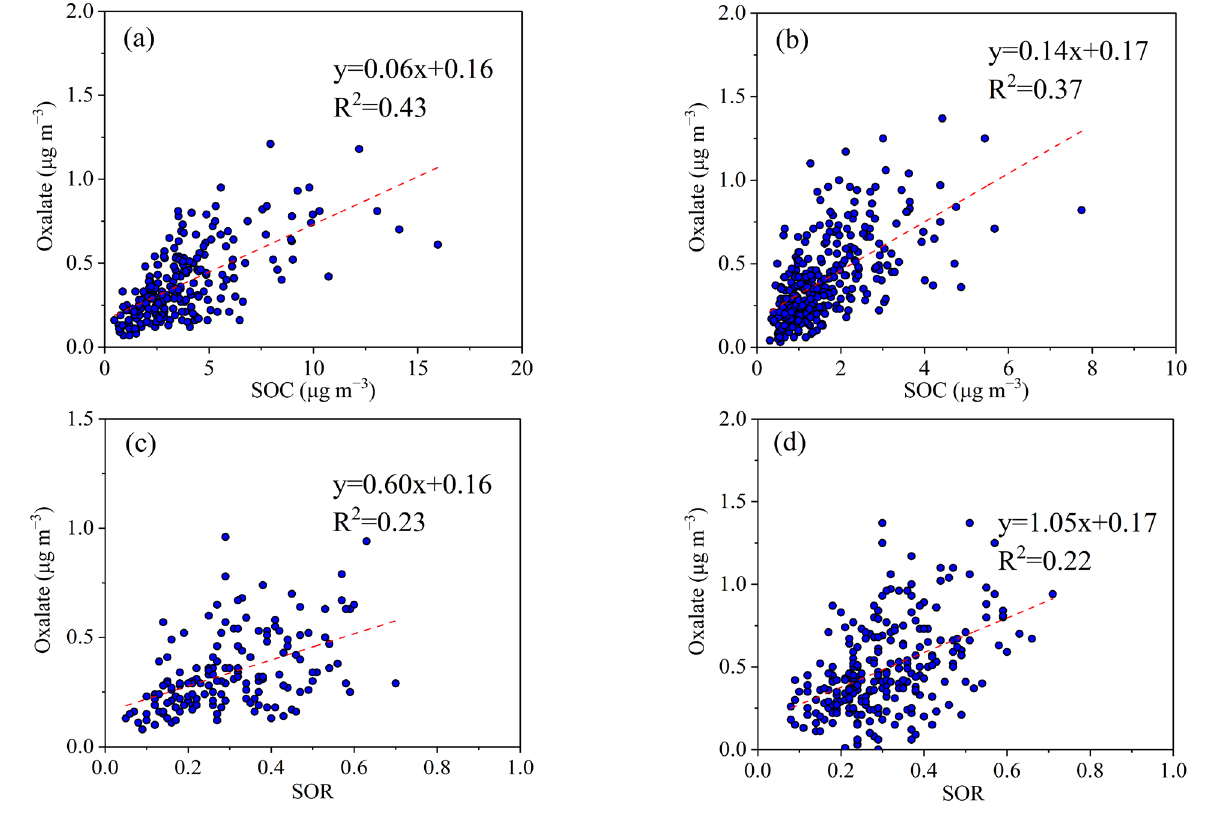
Figure 5. Correlations of oxalate with SOC for BS ( a ) and PD ( b ), and correlations of oxalate with SOR for BS ( c ) and PD ( d SOR for BS ( c ) and PD ( d ).